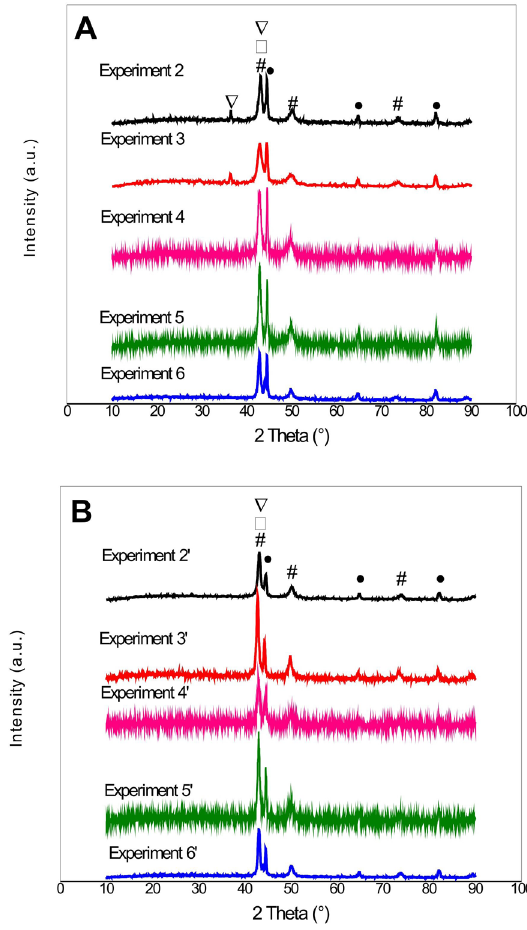
Figure 5. XRD analysis for the Cu-Sn coatings produced by (A) DC electrodeposition; (B) SPC electrodeposition. Legend of the